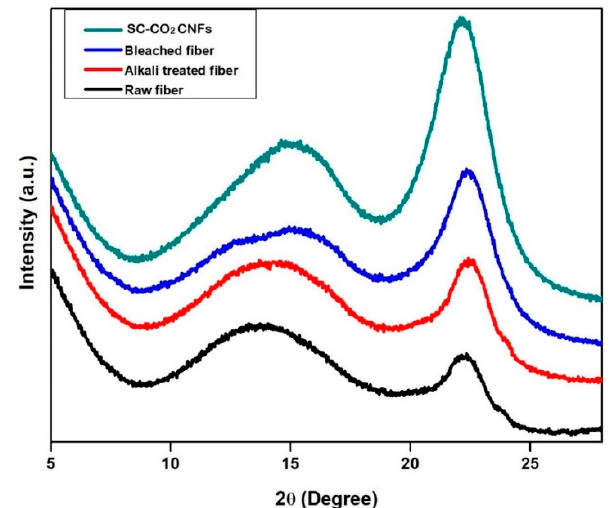
Figure 4. XRD of raw kenaf fiber, alkali treated kenaf fiber, bleached kenaf fiber, and SC-CO 2 extracted CNFs.